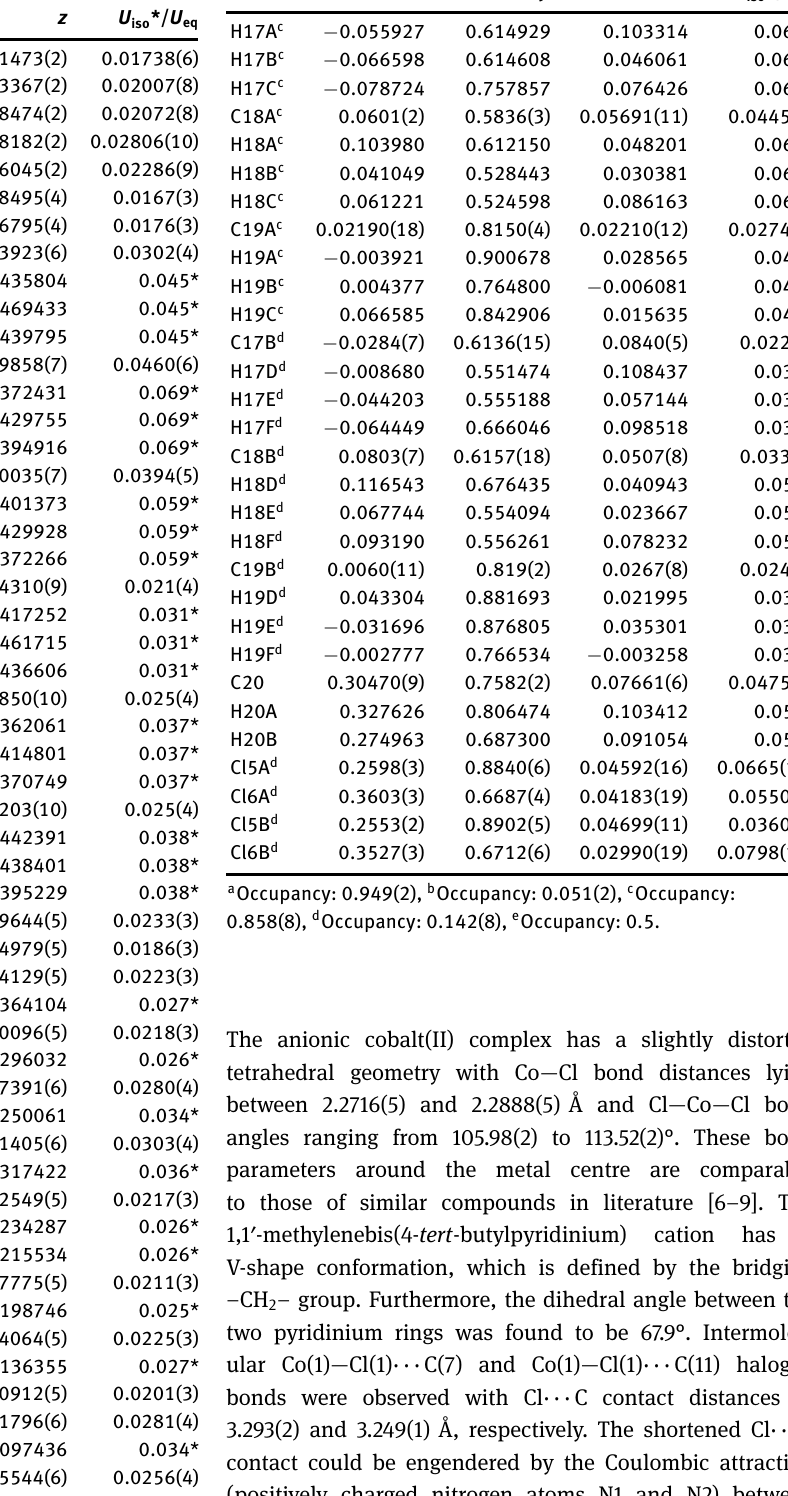
bonds were observed with Cl· · · C contact distances of 3.293(2) and 3.249(1) Å, respectively. The shortened Cl· · · C contact could be engendered by the Coulombic attraction (positively charged nitrogen atoms N1 and N2) between the 1,1′-methylenebis(4- tert -butylpyridinium) and [CoCl 4 ] 2 −